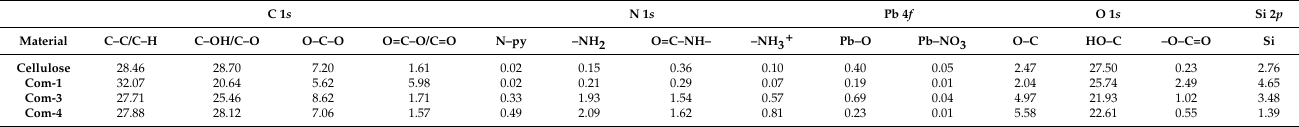
Table 1. Relative atomic concentration (%) for the different derivatives.